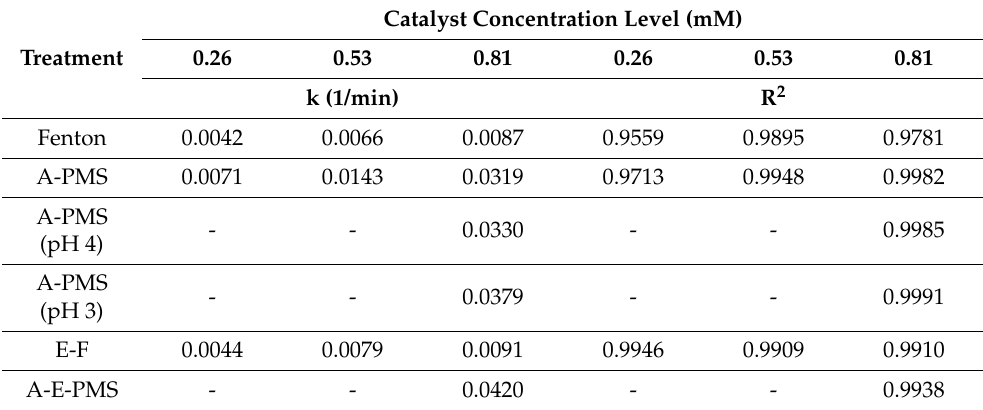
Table 2. Kinetic data obtained in the Fenton, A-PMS (at different pHs), E-F and A-E-PMS treatments.